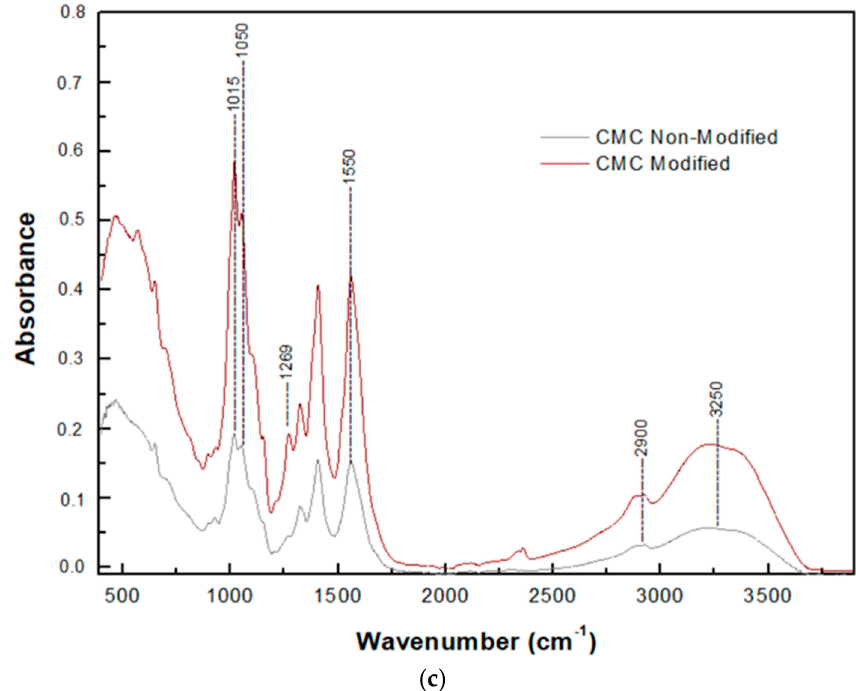
Figure 6. Infrared (ATR) spectra of chitosan ( a ), chitosan/gelatin ( b ) and CMC membranes ( c ) before and after their enzymatic modification with ferulic acid by laccase from Agaricus bisporus .